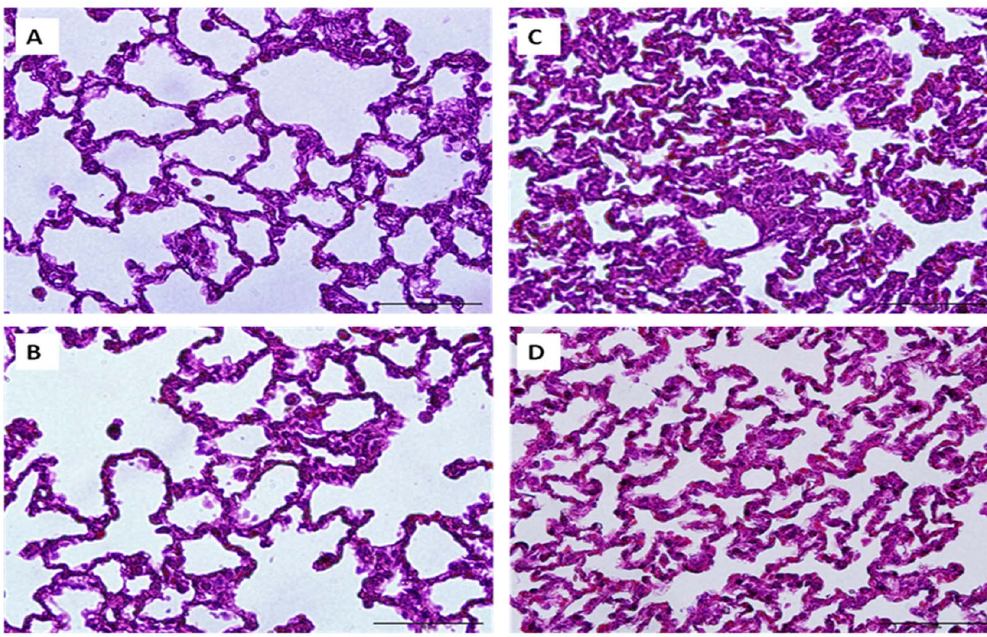
Figure 6. Histological effects of ursolic acid (UA) on lungs of rats after a sham operation (Sham) or trauma–hemorrhagic shock (T– H). Representative photomicrographs of lungs of (A) sham animals receiving vehicle, (B) sham animals receiving UA, (C) T–H animals receiving vehicle, and (D) T–H animals receiving UA. Tissue sections were stained with hematoxylin-eosin, examined at an original magnification of 6 400, and photographed.